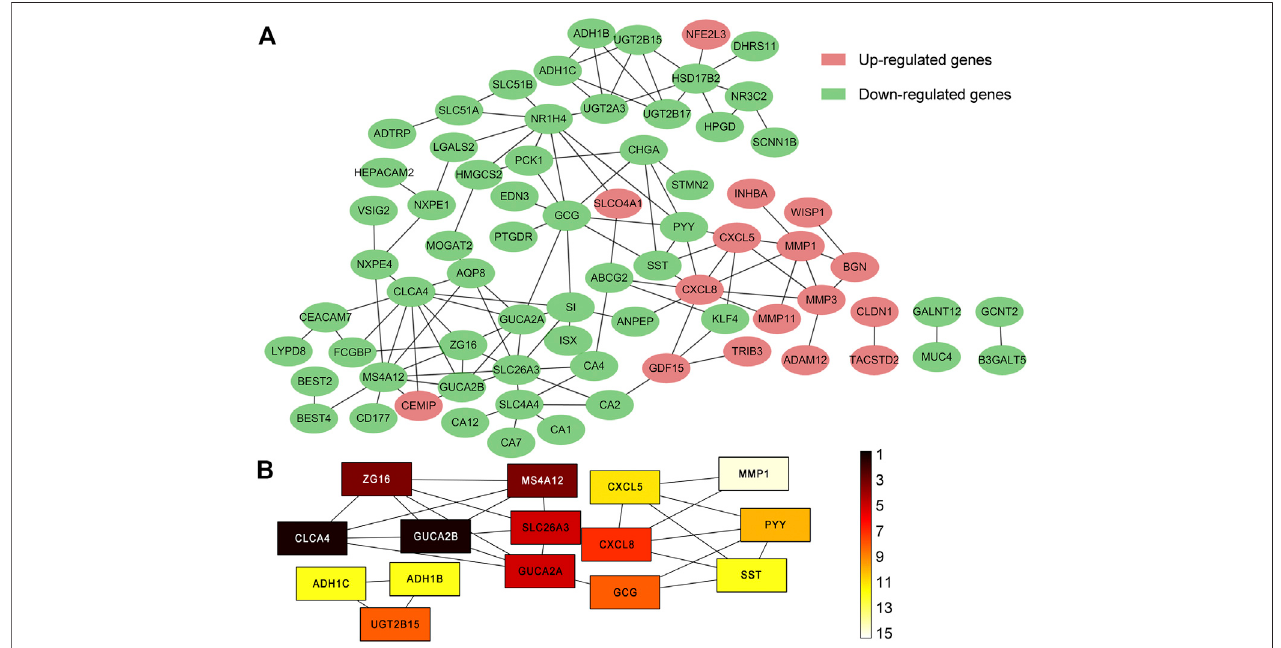
FIGURE 2 | PPI network of 105 common DEGs built by STRING and Cytoscape module analysis. (A) 73 out of the 105 DEGs were contained in the PPI network complex. The 73 nodes and 122 edges represent the interaction of proteins. Red circles indicate the up-regulated DEGs and green circles indicate the down-regulated DEGs; (B) Therankings ofthetop15hub genesidenti fi ed bythe Cytoscape plugin cytoHubba MCC. 9differentcolorsfrom black towhitewaschosentoshow therank of the hub genes.